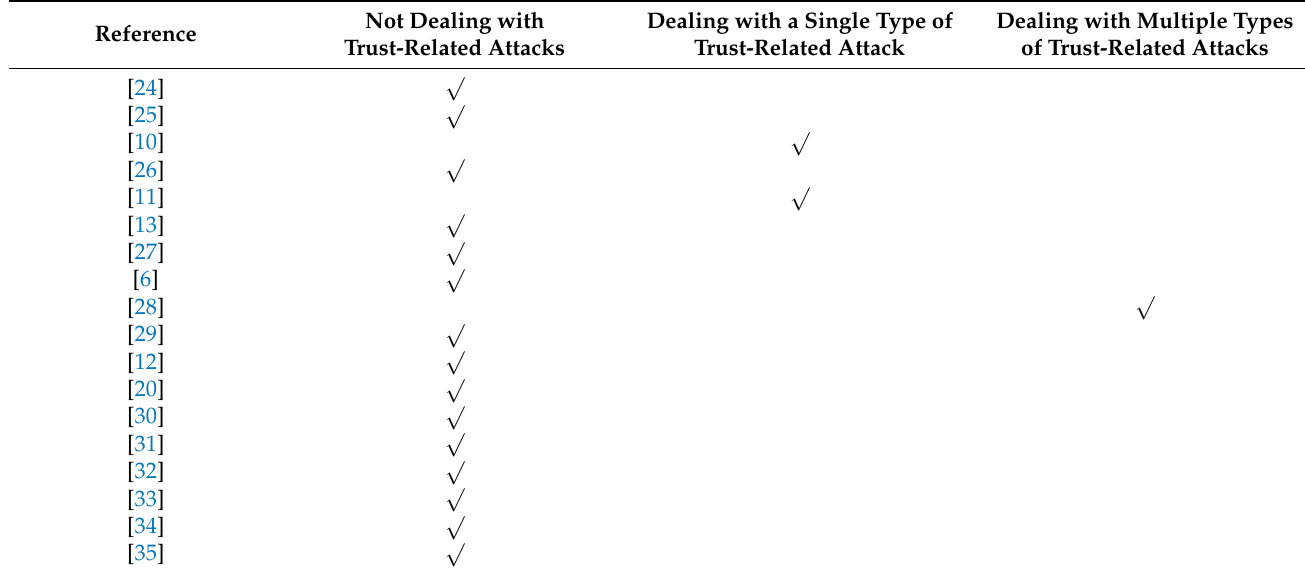
Table 2. Summary of existing